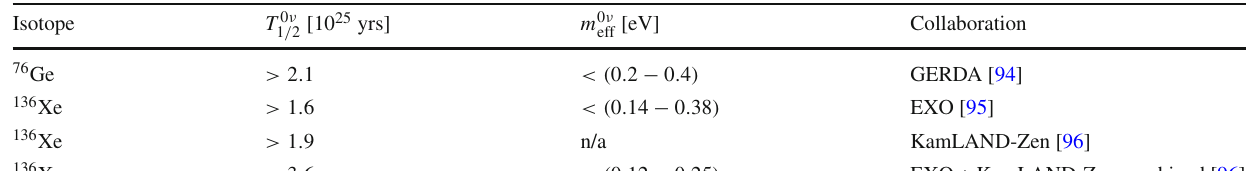
and upper lim- 1 / 2 of neutrinoless double beta eff